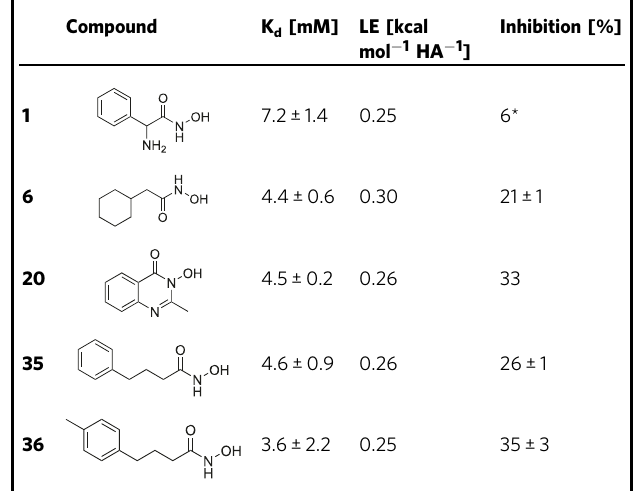
Table 1 Overview of hydroxamate 1 analogs for targeting LecA.